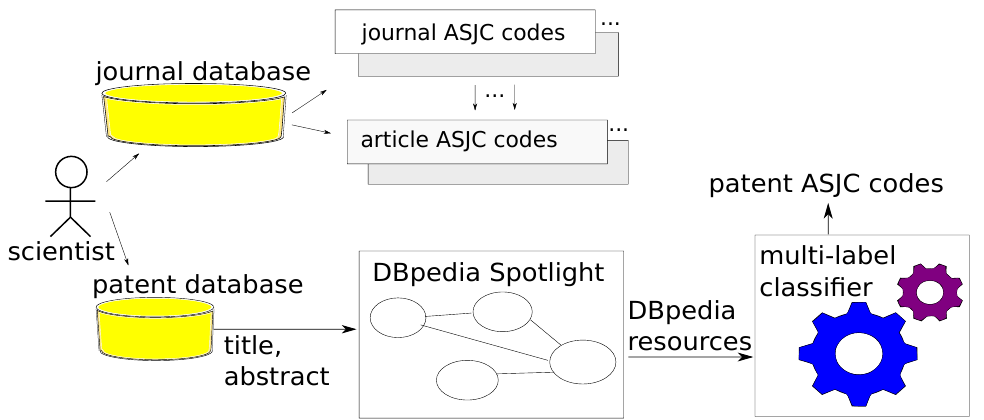
Figure 3. Determining ASJC codes for papers and